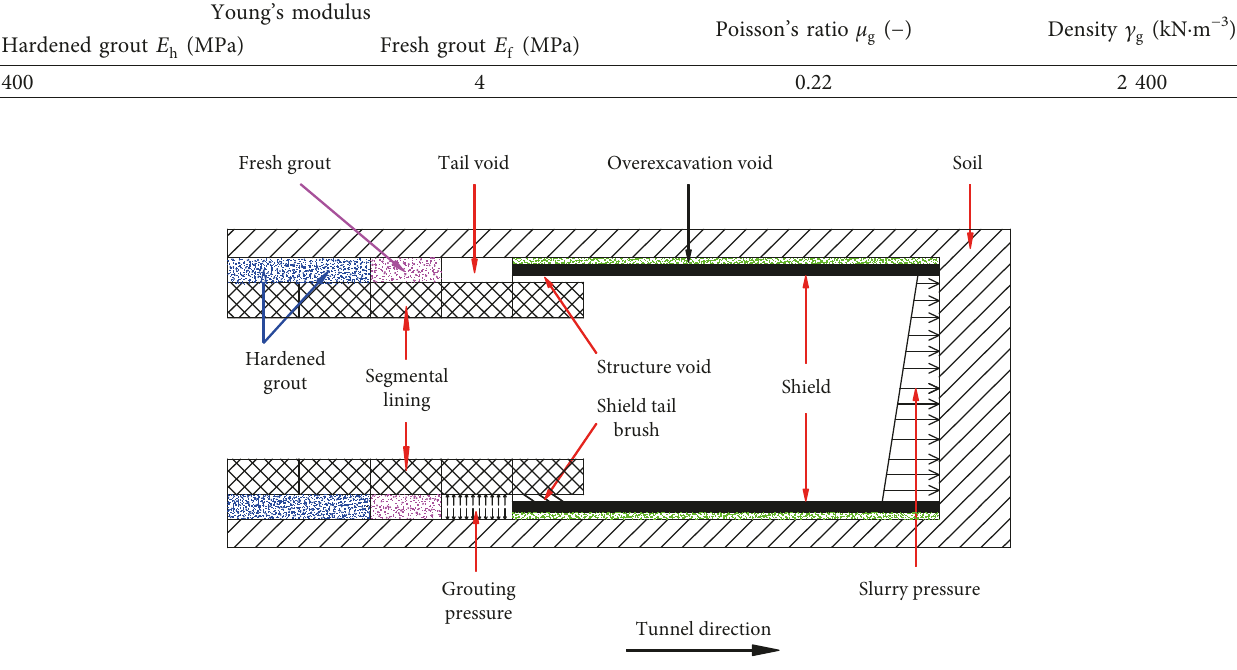
Figure 7: Layout of the slurry shield model. Table 2: Physicomechanical parameters of surrounding rock and tunnel segment.